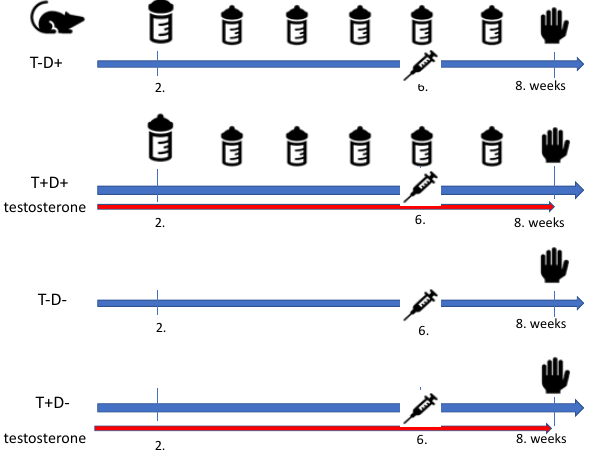
Figure 4. Timeline of chronic treatment. Adolescent Wistar rats were grouped as the following: half of the animals (T+D+, T+D-) received transdermal testosterone treatment (0.0333 mg/body weight grams 5 times weekly) for 8 weeks. Half of the testosterone-treated and half of the non-treated animals fed low vitamin D chow (T-D-, T+D-) while the rest received adequate vitamin D supplementation (weekly 1,4 NE/body weight grams per os on the 3rd, 4th, 5th, 6th and 7th week after a 500NE saturation on the 2nd week) (T-D+, T+D+). The animals were sacrificed on the 8th treatment week and ex vivo experiments were performed.